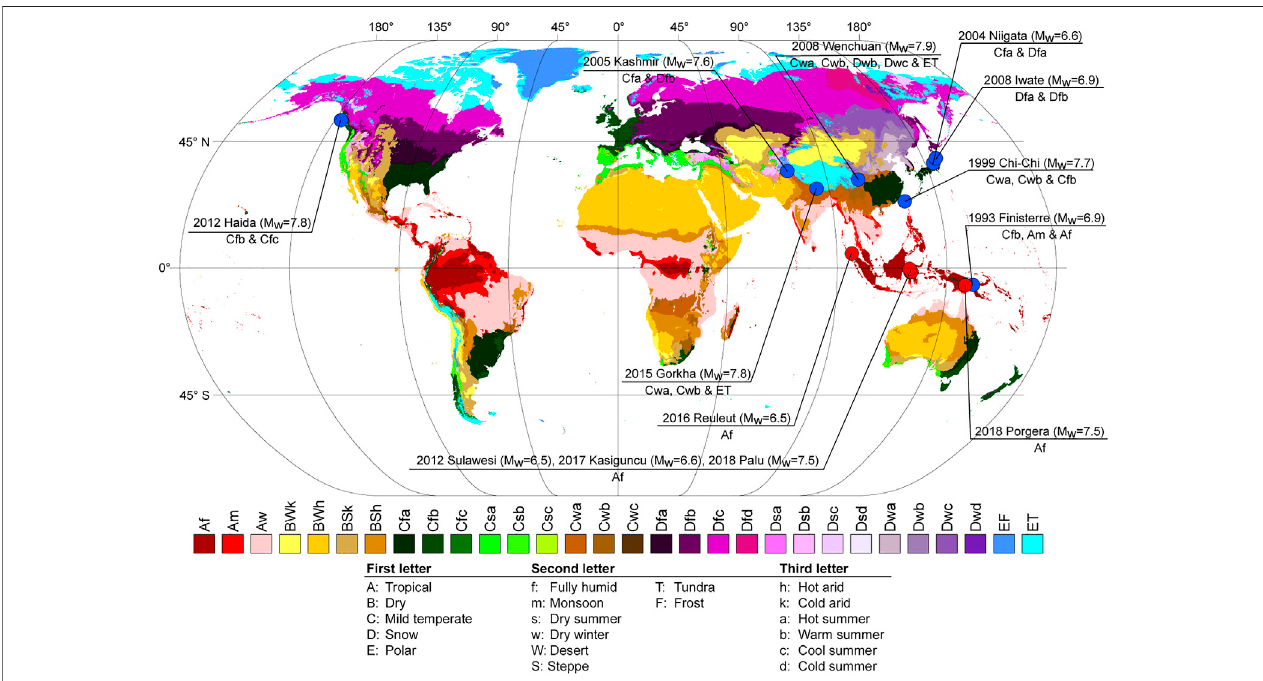
FIGURE 1 | World map of the Köppen-Geiger climate classi fi cation (Kriticos et al., 2012) overlaid by the spatial distribution of cases (blue points) in which post- seismiclandslideevolutionprocesseswereexamined via multi-temporallandslideinventories.Redpointsindicatethesiteswherewemappedmulti-temporalinventories for this